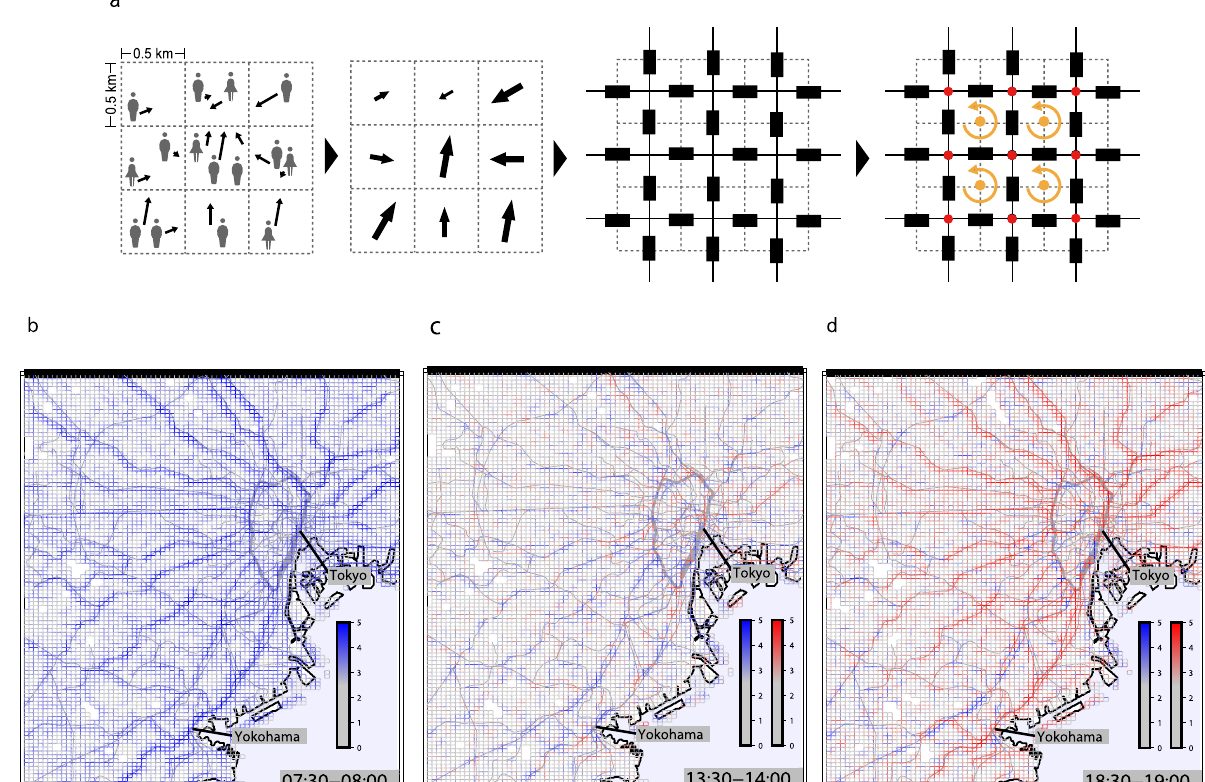
Figure 1. Definition of the imaginary electric circuit and observed currents. ( a ) Schematic figures demonstrating the way we regard the human flow as electric current. The mean velocity of people in each cell is calculated by evaluating their average velocity components over those people who are moving in the square during the observation interval of 30 min. The current and resistance were defined between adjacent cells. Rotation is defined at the orange dots where the four cells meet, and the potential is defined at the red dots in the center of the cell. ( b – d ) Current patterns on the map in the morning, afternoon, and evening. The red lines show the currents with different direction compared to the morning current pattern. The strength of the flow was plotted on a logarithmic scale. The gray lines in the map represent the